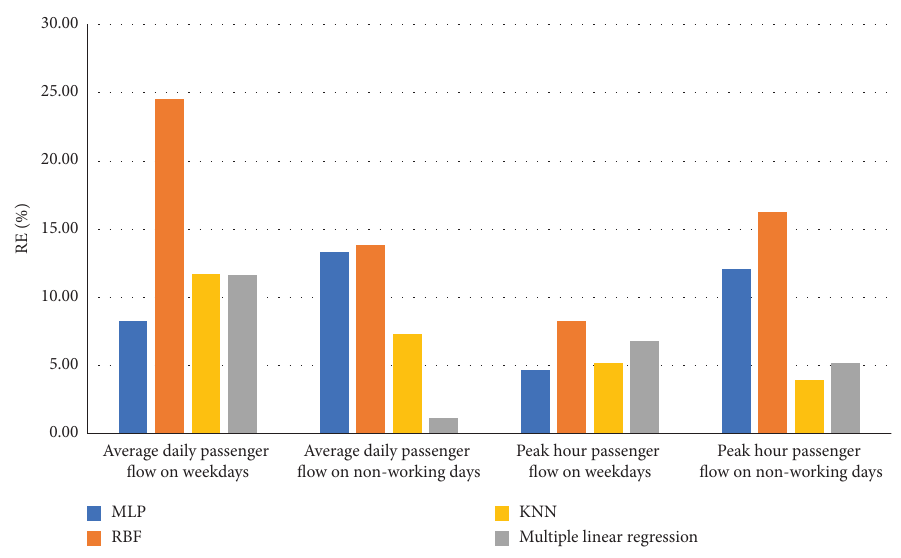
Figure 21: Comparison of prediction results of Sun Palace